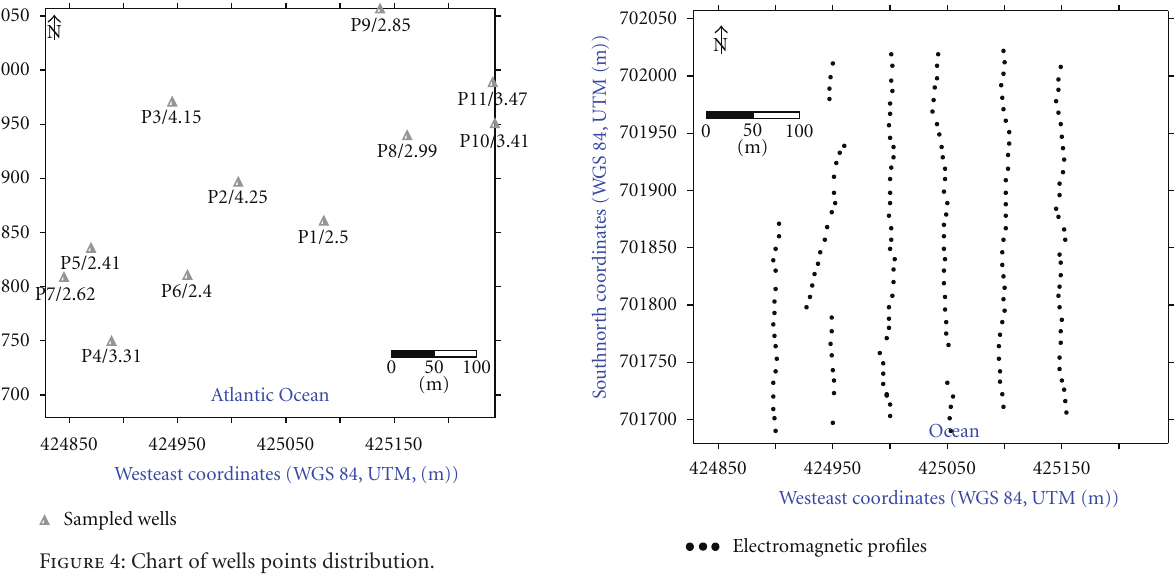
Figure 5: Chart of electromagnetic